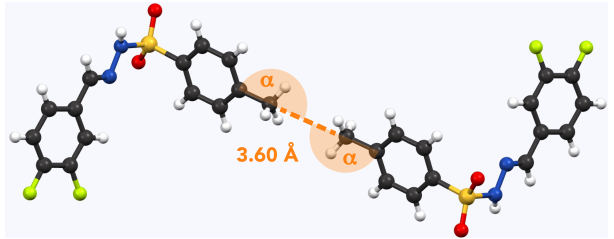
Figure 6. Example of methyl pairs in the crystal structure of 12 (NUQDUA; Wang and Yan, 2015). The distance between them is 3.60Å (measured carbon to carbon). Respective angles (measured carbon to carbon to carbon) are α = 172 ◦ .